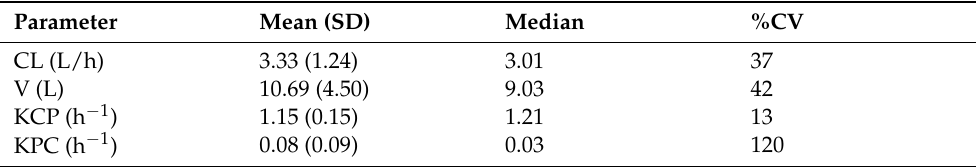
Table 2. Estimates of piperacillin pharmacokinetic parameters for the final covariate